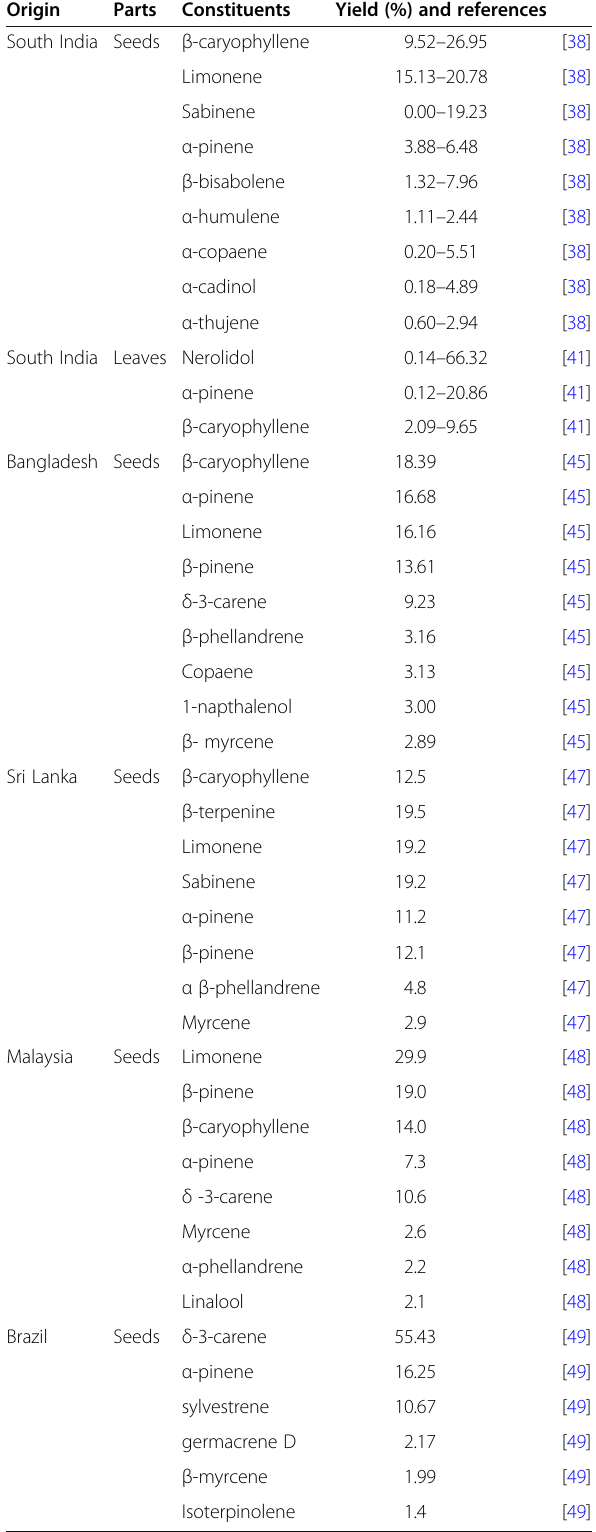
Table 3 Composition of major essential oils of Piper nigrum from various